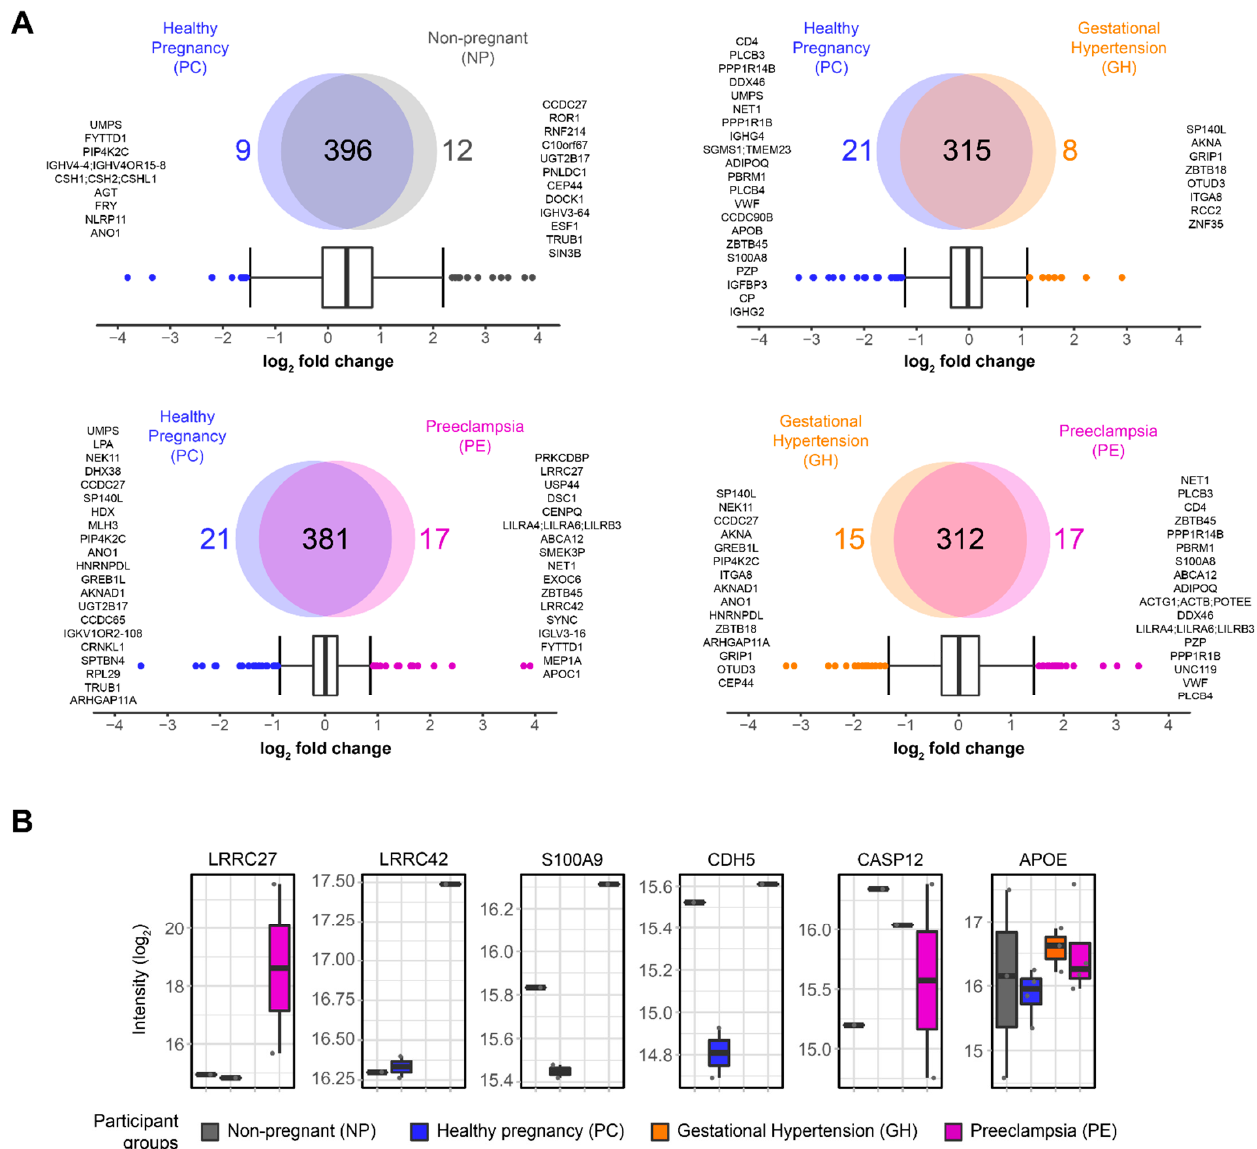
Figure 3. Platelet proteomics of non-pregnant (NP), healthy pregnancy (PC), gestational hyperten- sion (GH), and preeclampsia (PE) patients. ( A ) Quantification results and multiple group compari-